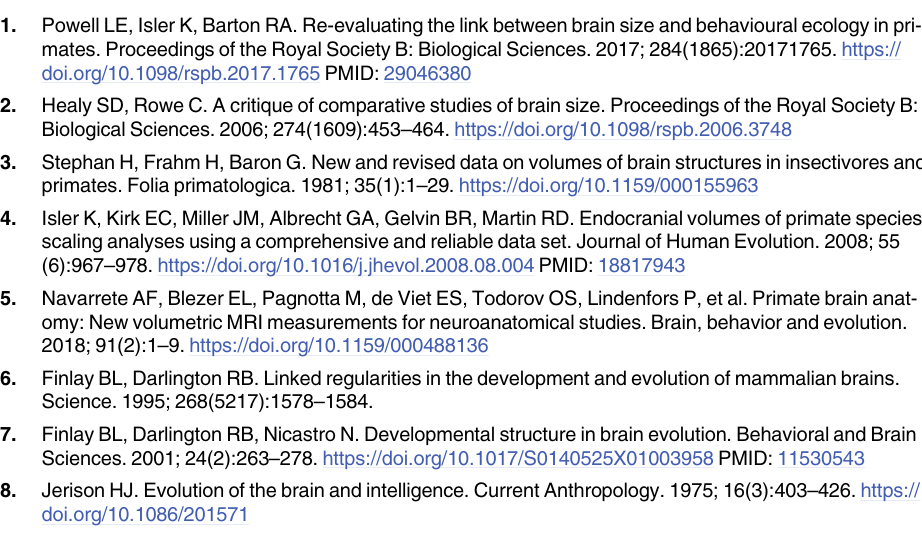
S12 Table. Dunbar’s number [19]. S13 Table. Data used to reevaluate Dunbar